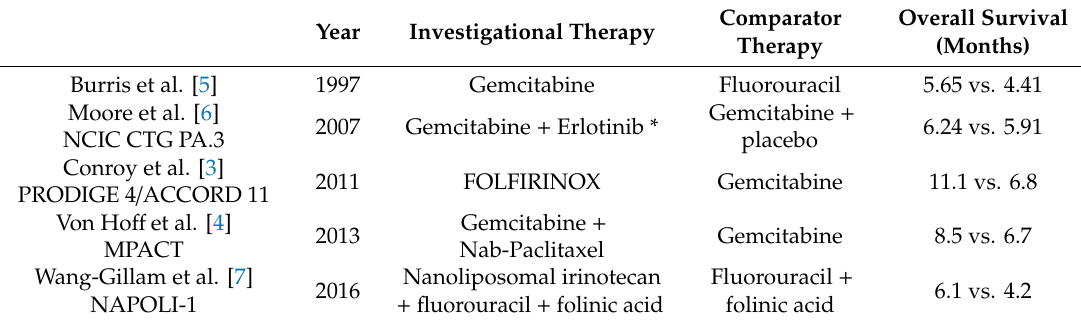
Table 1. Landmark clinical trials leading to the current empiric chemotherapy regimens for advanced pancreatic ductal adenocarcinoma (PDAC). * Trial design did not include stratification based on KRAS or EGFR mutational status.